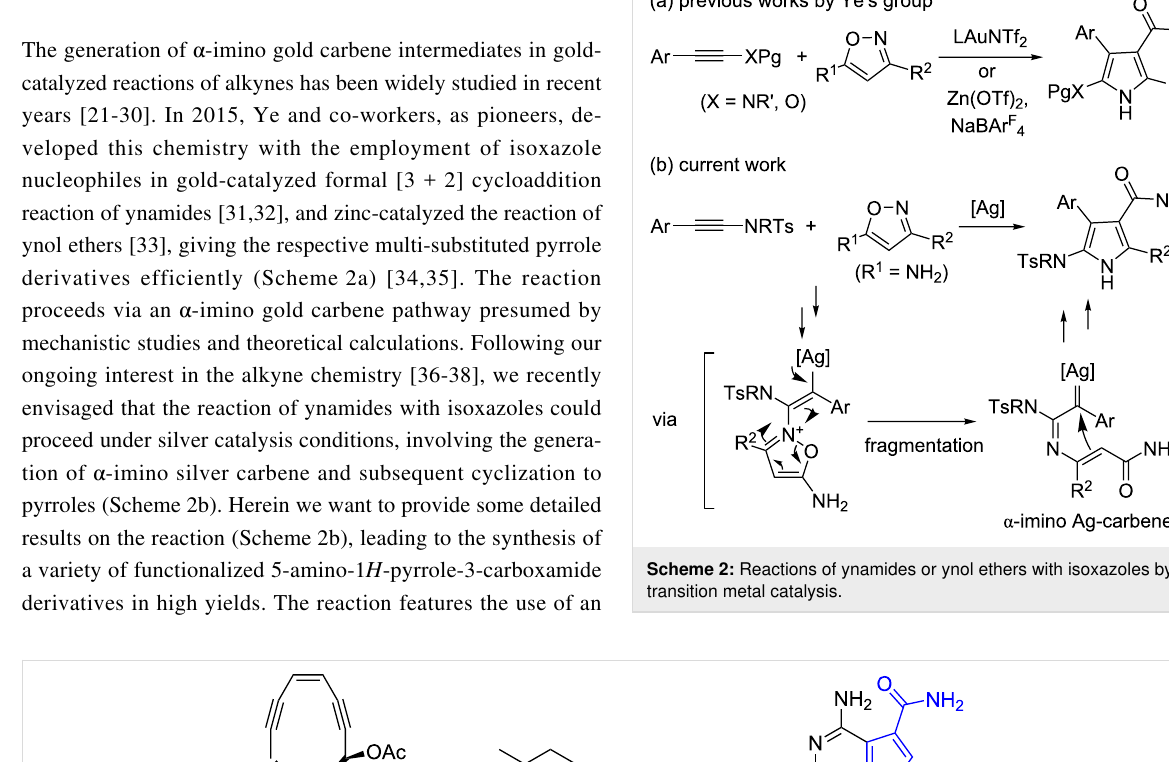
converted into complex polycycles by Ag-carbenoid-initiated cascades [16]. Recently, Zhu’s group developed a tandem 1,3 ‑ dipolar cycloaddition/cyclopropanation silver-catalyzed reaction of enynals with alkenes [17]. In our previous studies, this silver carbene species could be also involved mechanisti- cally in the Ag-mediated reaction of enynals with conjugated dienes [18] and the homodimerization of enynals [19,20]. So, of silver carbene species from non-diazo precursors are of great value for getting some insight into silver-carbene